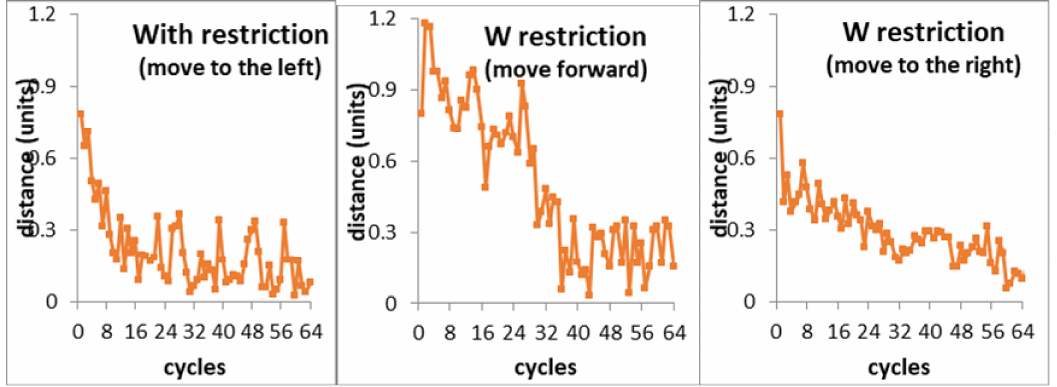
Figure 12. Learning to move to the left, forward, and to the right.